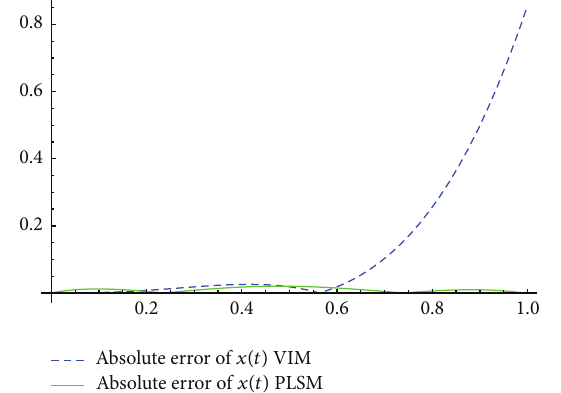
case of fractional systems of 𝑛 ≥ 3 nonlinear differential